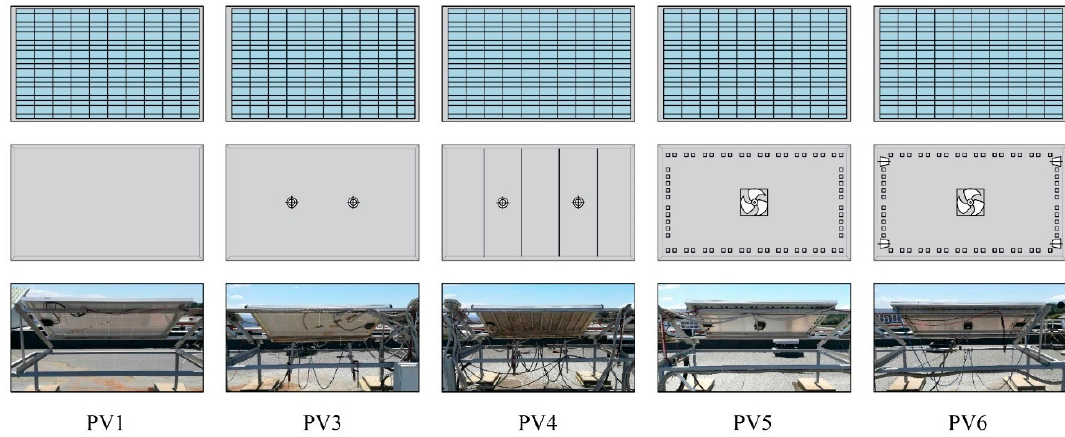
Figure 4. Schematic representation of the different cooling systems implemented on the photovoltaic modules of the ex-